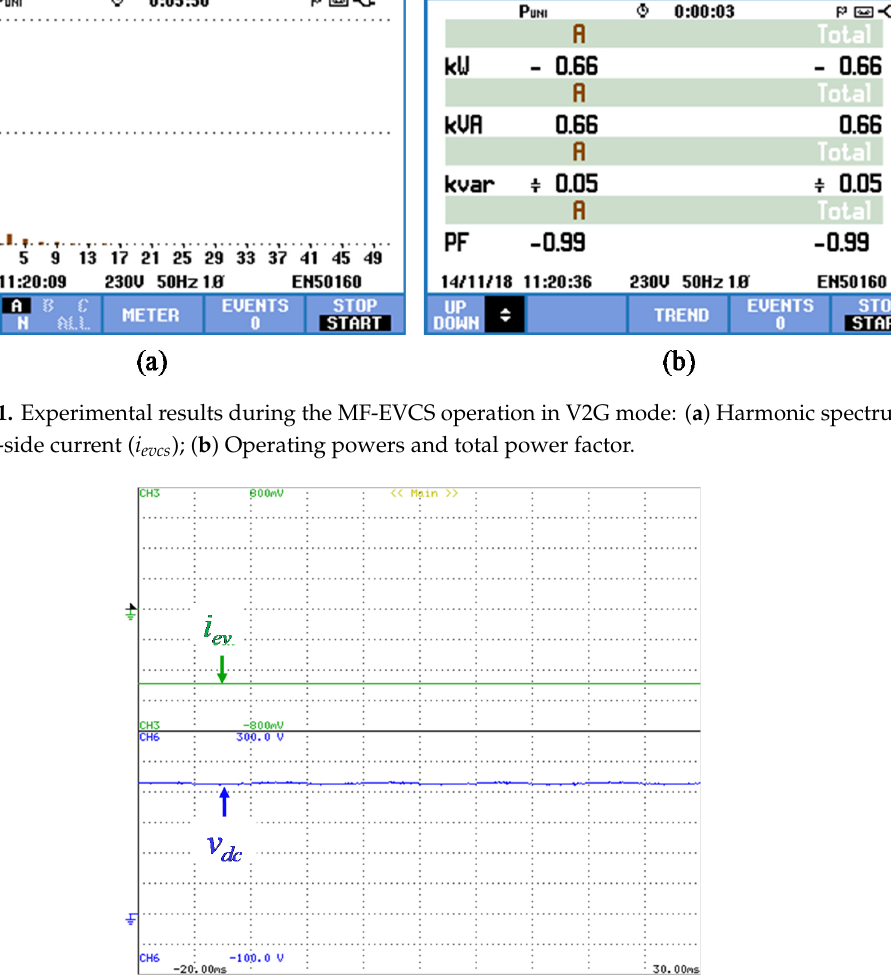
Figure 12. Experimental results during the MF-EVCS operation in V2G mode: Current in the EV battery ( i ev : 2 A/div) and dc-link voltage ( v dc : 50 V/div).